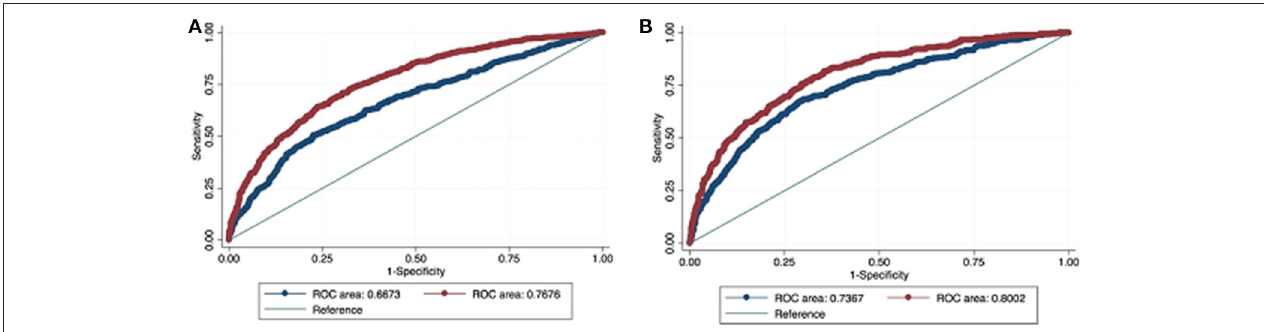
FIGURE 1 | Receiver operating characteristic (ROC) curve analysis comparing base model (red line = age, PSA, and DRE) with the full model (blue line = age, PSA, DRE, PVol, PVR) in predicting prostate cancer (A) and clinically significant prostate cancer (B) .